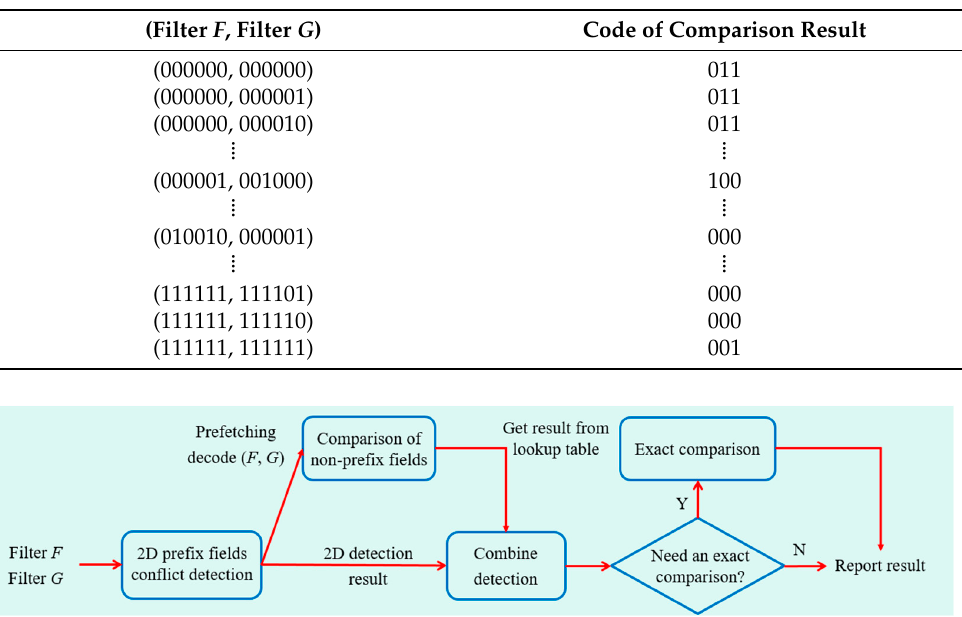
Figure 3. The process flow of 5D conflict detection.